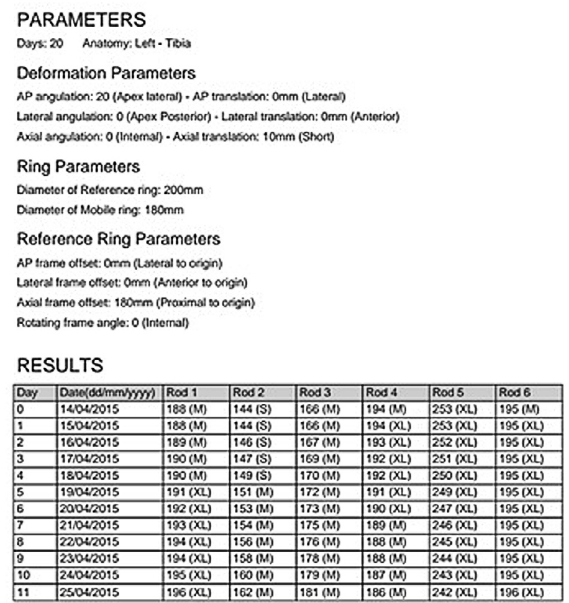
Figure 2. An example of a correction prescription.